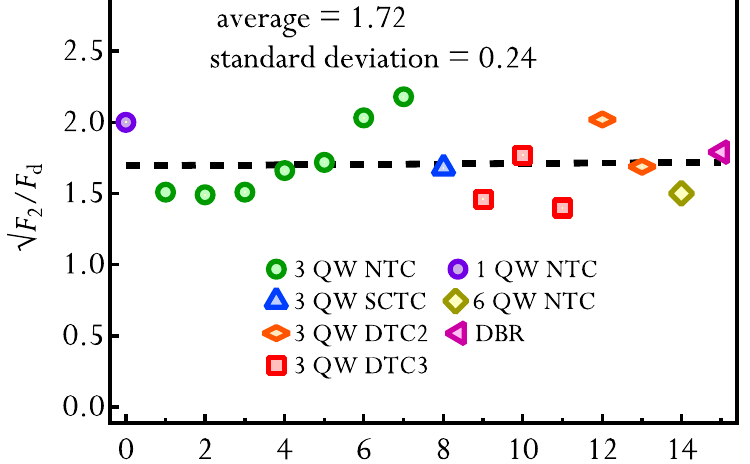
Figure 10. Ratio √ F / F for different samples for which we measured the damage 2 d threshold, including samples with different absorber sections and a DBR